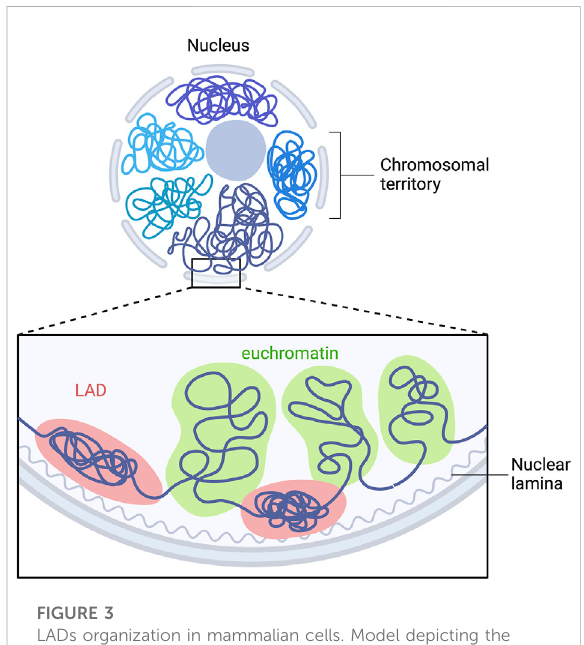
FIGURE 3 LADs organization in mammalian cells. Model depicting the interaction of multiple LADs with the nuclear lamina. Repressed LADs are located at the nuclear periphery and are composed of “ gene-desert ” regions, which are enriched in heterochromatin marks. Euchromatin is located within the nucleoplasm and is transcriptional active. Adapted from “ Chromosome Organization in Nucleus: TADs ” , by BioRender. com. Retrieved from https://app.biorender.com/biorender-